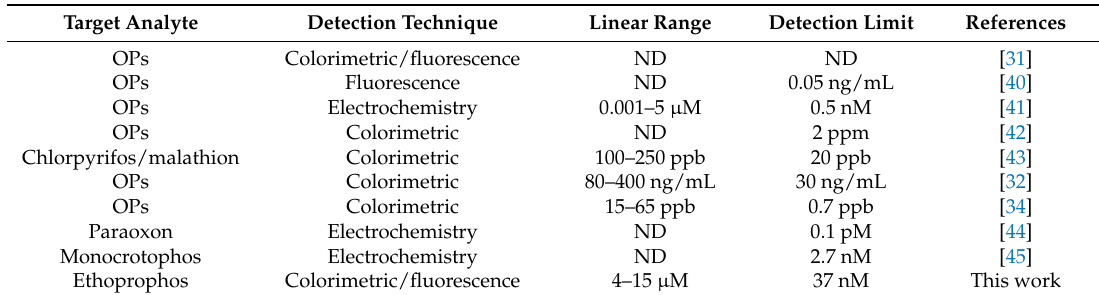
Table 2. The reported AuNP-based OP